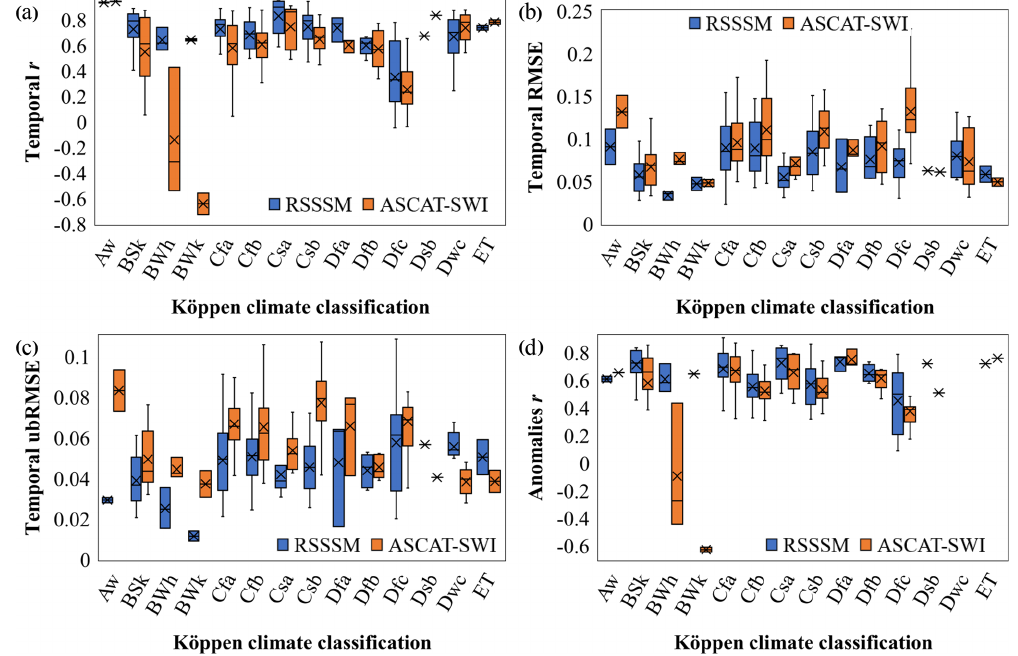
Figure 8. Comparison of the temporal accuracy between RSSSM and ASCAT-SWI in different Köppen–Geiger climatic regions. The four indexes are (a) r , (b) RMSE, (c) ubRMSE, and (d) anomalies R